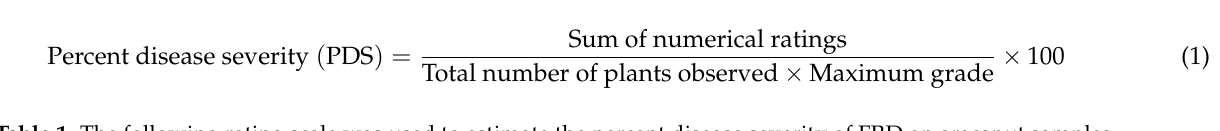
Table 1. The following rating scale was used to estimate the percent disease severity of FRD on arecanut samples. Rating